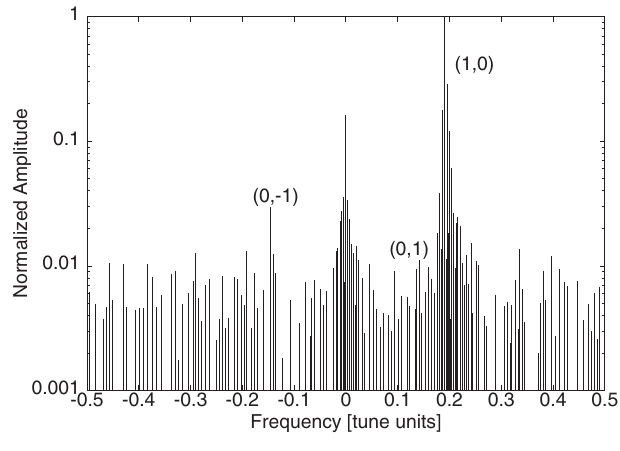
FIG. 32. Horizontal Fourier spectrum with compensation